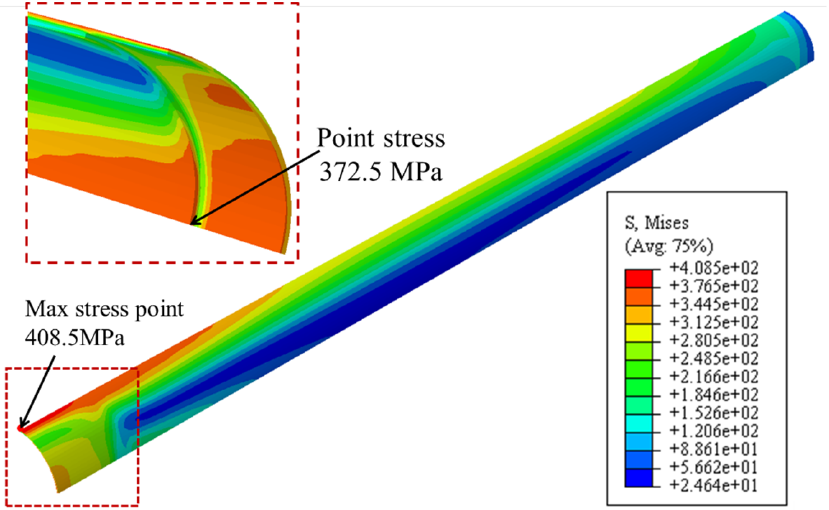
Figure 12. Stress distribution of the pipeline at the collapse pressure (repaired pipe).